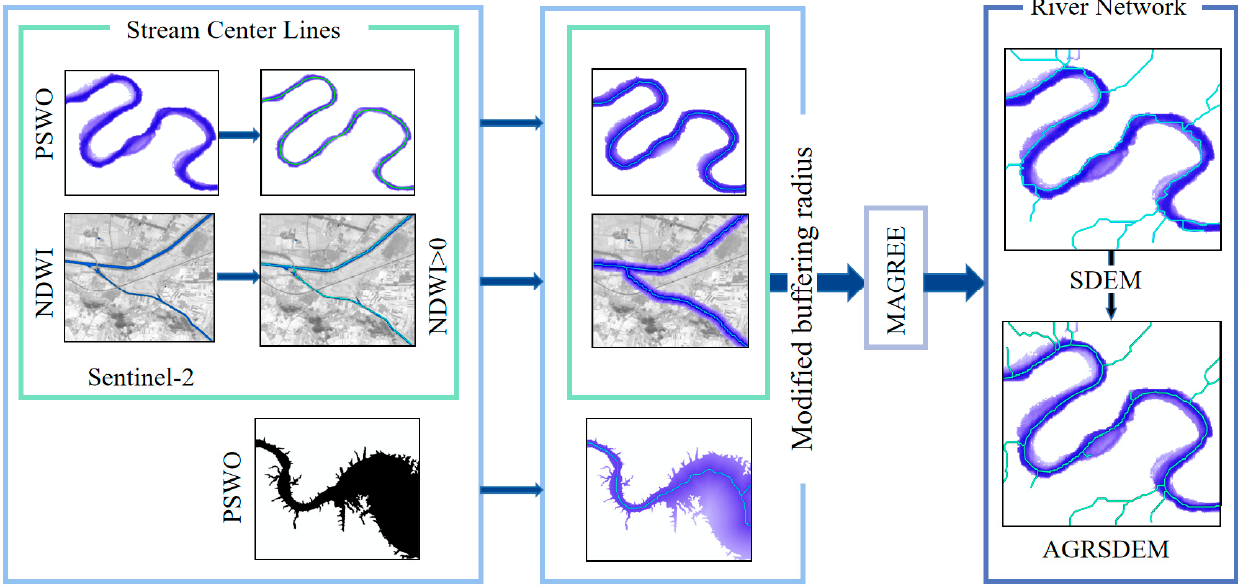
Figure 5. The flow chart of setting a flexible parameter value of the buffering radius of modi- fied